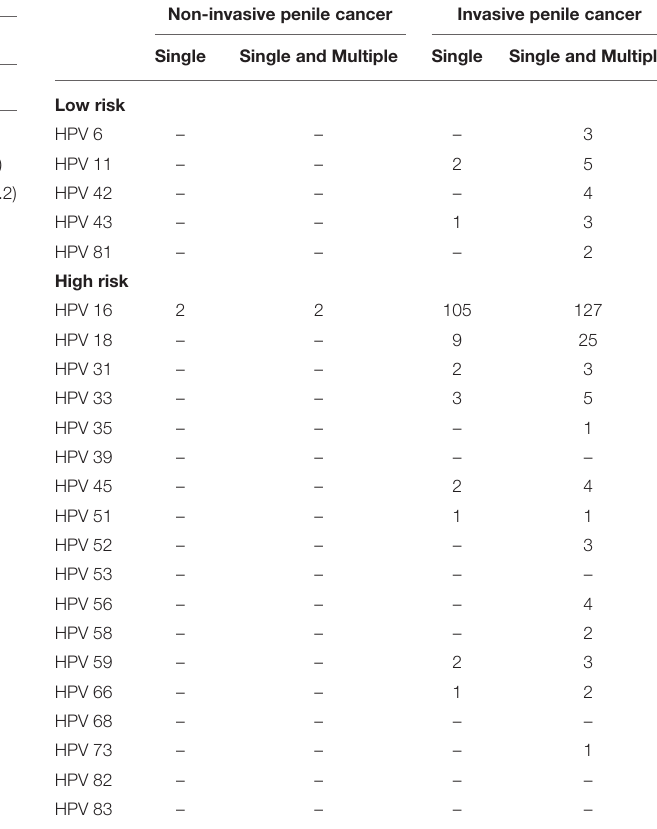
TABLE 2 | Human papillomavirus (HPV) type-specific relative contribution among HPV DNA-positive penile